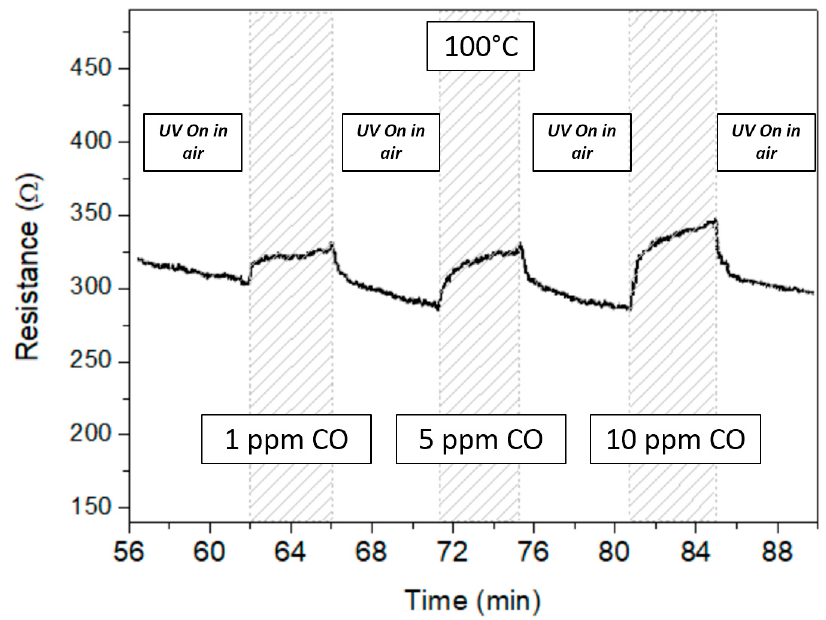
Figure 7. Transient sensor response at T = 100 °C and different CO concentrations in “UV On in air” mode.